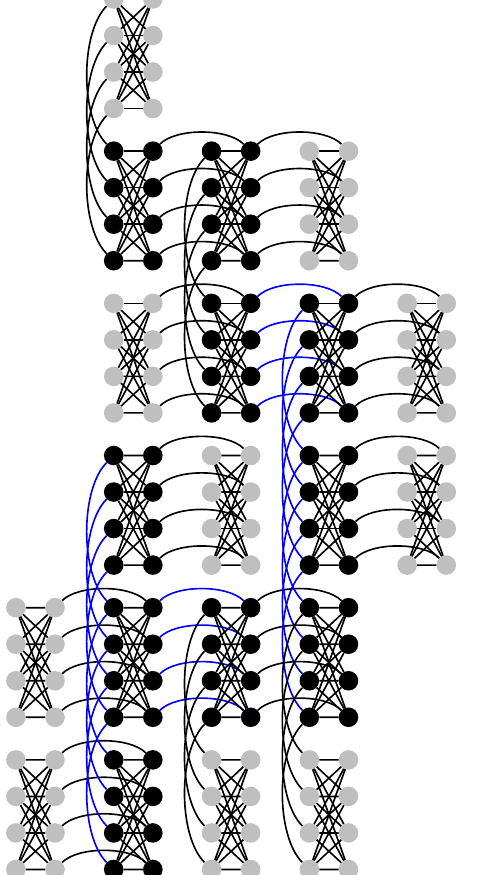
Figure 9 | Larger problems that contain the tunnelling probe ‘motif’ as subproblems. As in Fig. 1, the black (grey) cluster has a strong h R ¼ (cid:2) 1 (weak h L ¼ 0.44) local field. The black clusters are connected in a glassy manner to make the problem less regular: all connections between any two neighbouring black clusters are set randomly to either (cid:2) 1 or þ 1. The (cid:2) 1 connections are depicted in blue.